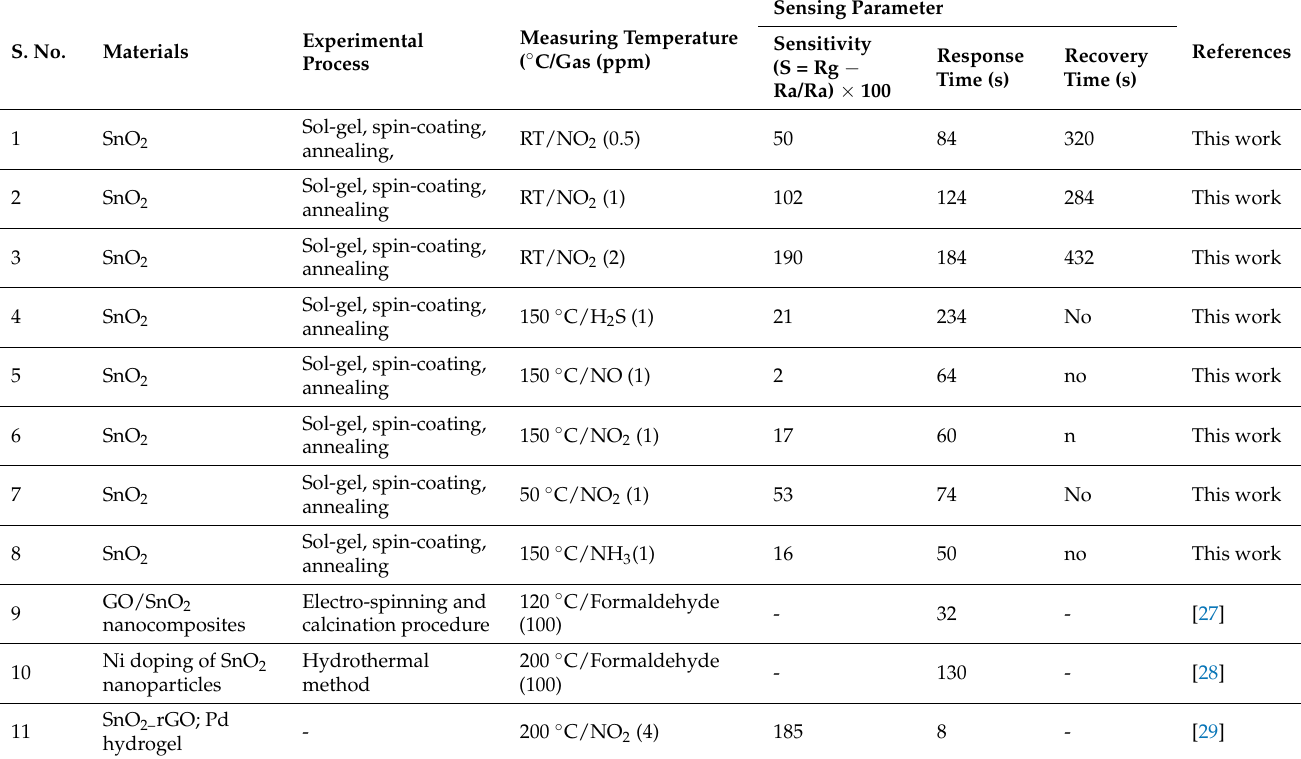
Table 2. Comparison table for different gases and